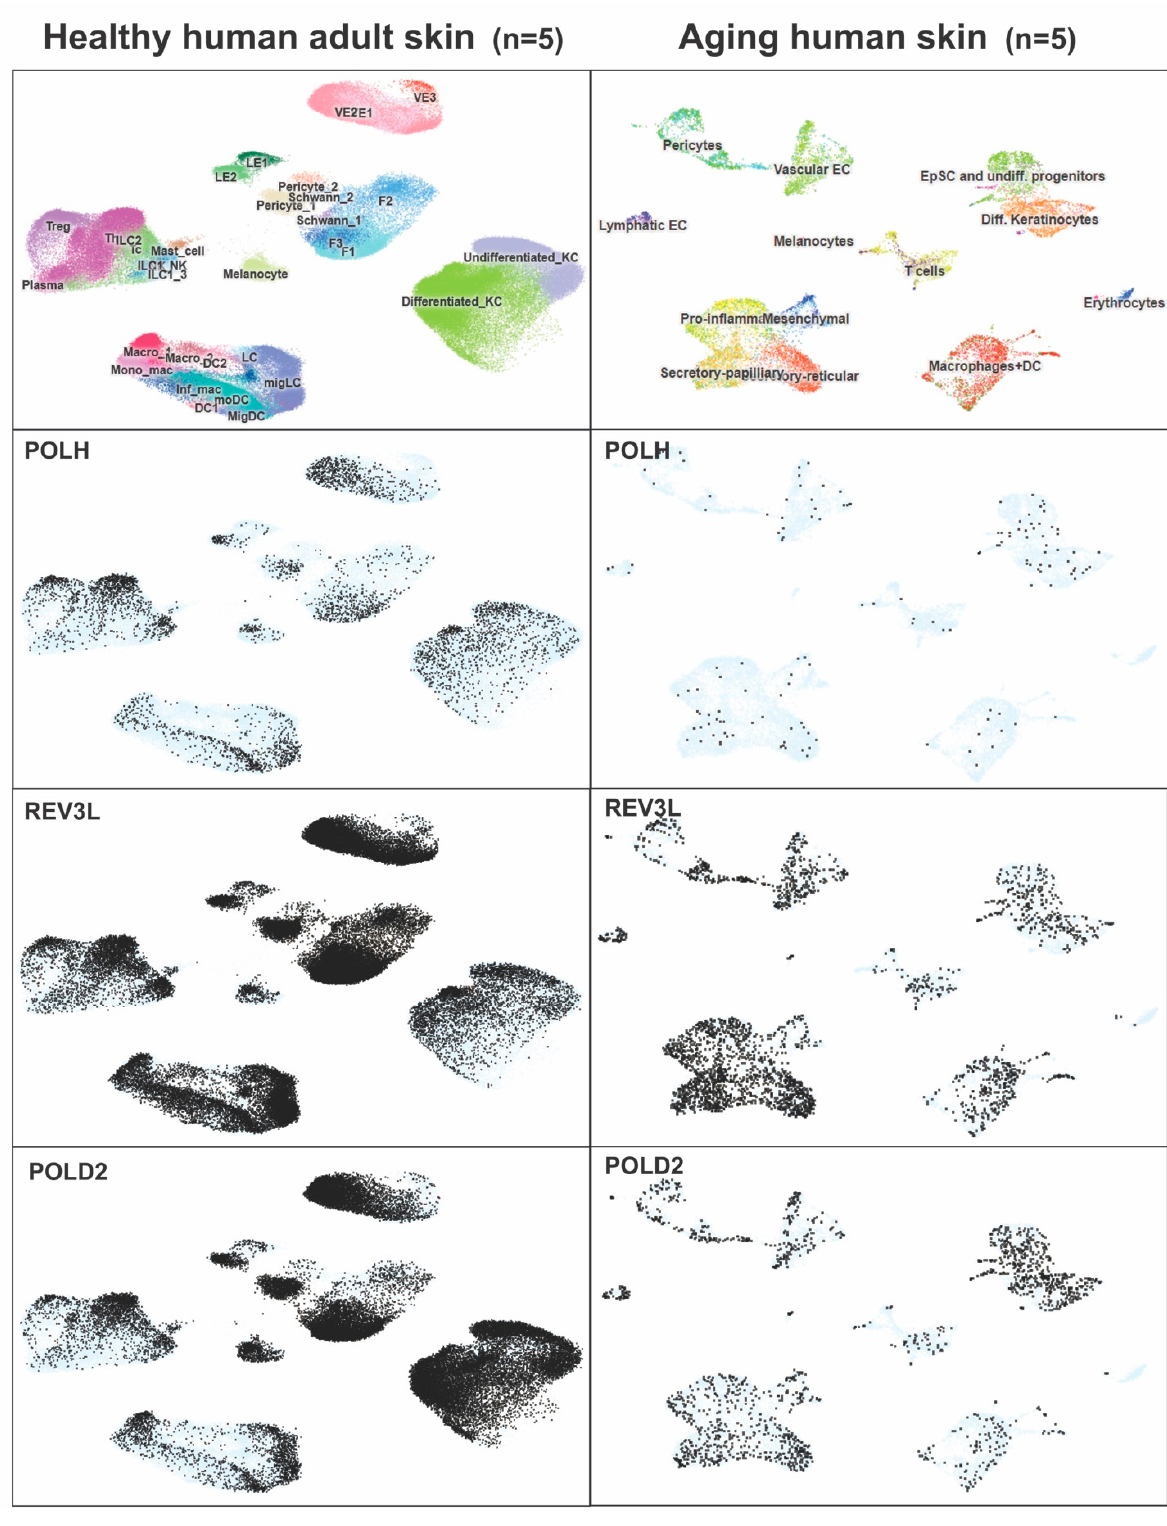
Figure 3. Single cell RNA seq data showing expression of POLH in human healthy and aging skin. This dataset was generated from 500,000 cumulative single cells (healthy) and 5000 fibroblasts of aging human skin. Data are plotted using UMAP (Uniform Manifold Approximation and Projection for Dimension Reduction). Gene expression is highlighted in black dots; however, light blue shade represents no